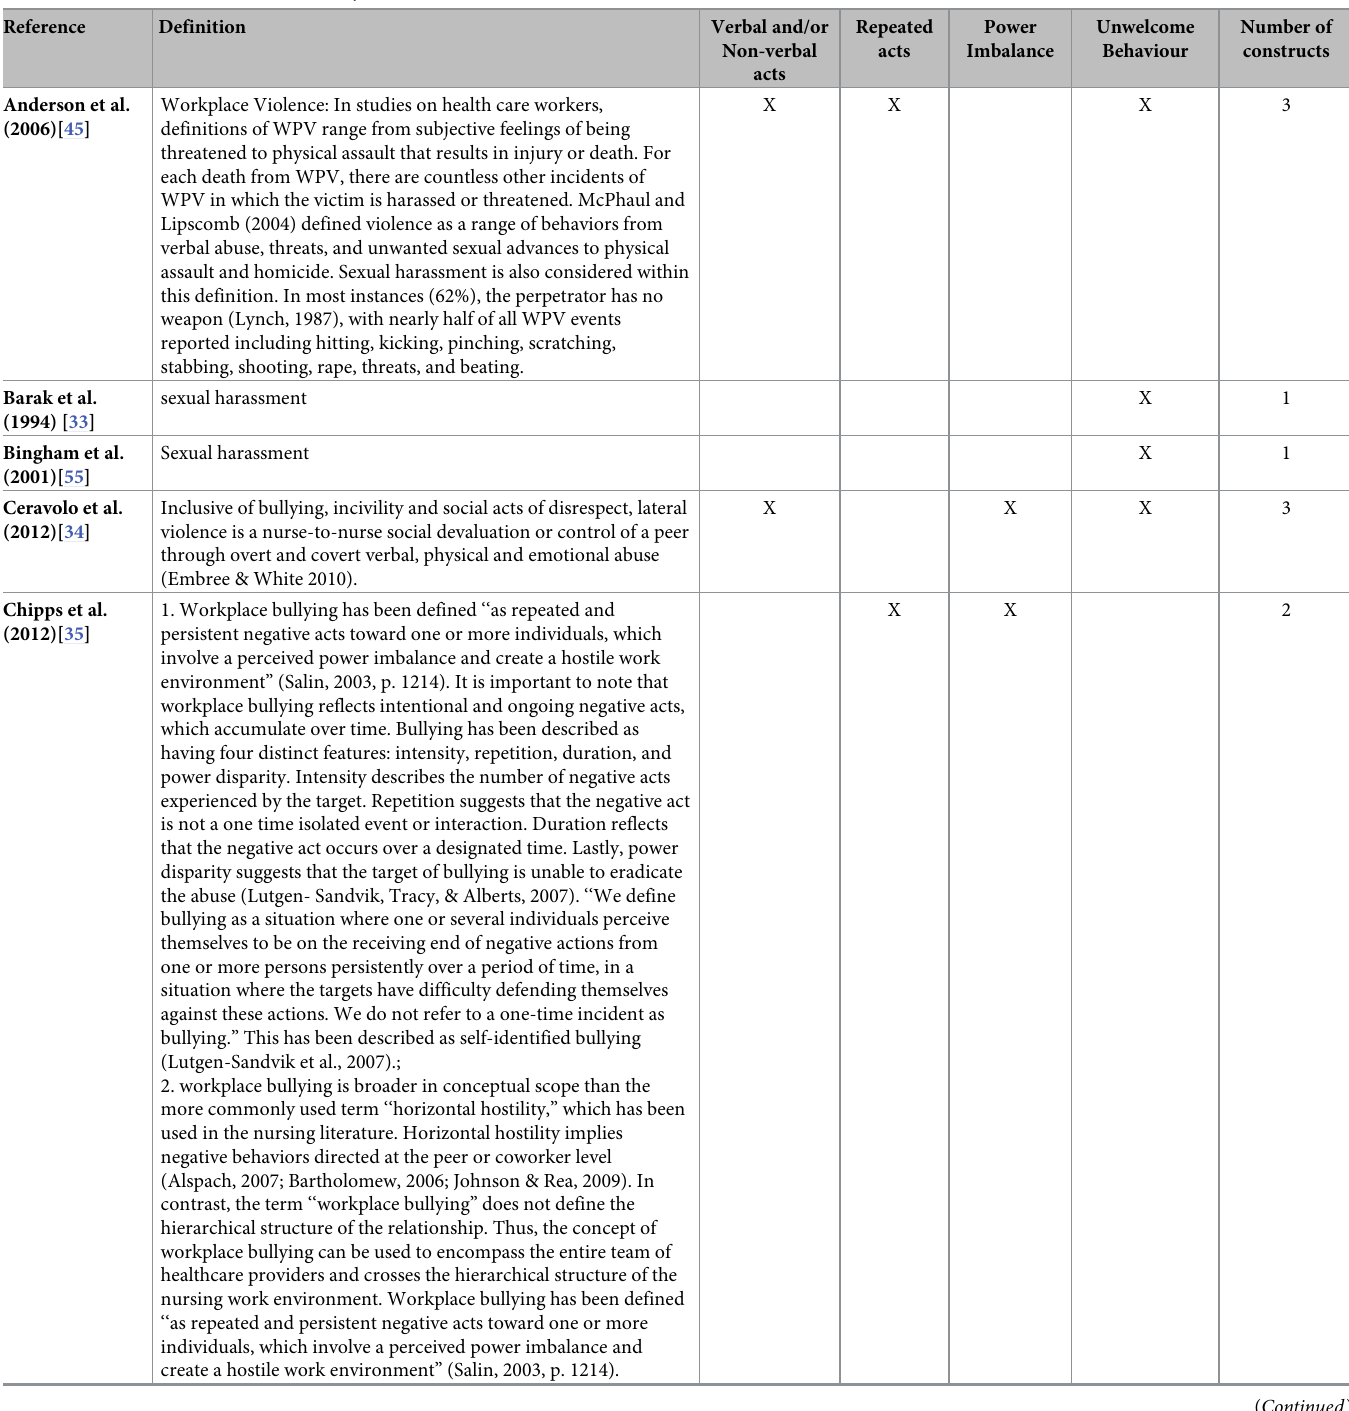
Table 3. Definitions abstracted to incivility